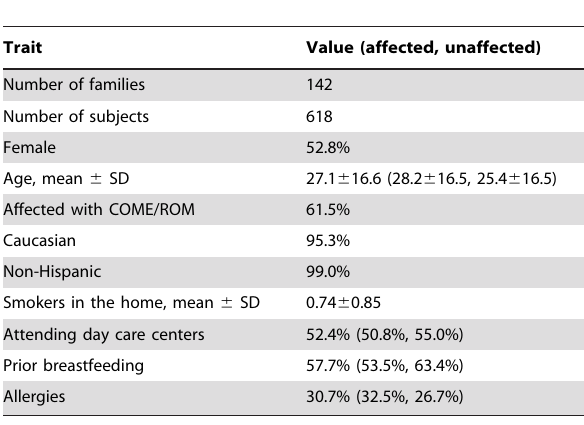
Table 2. Participant